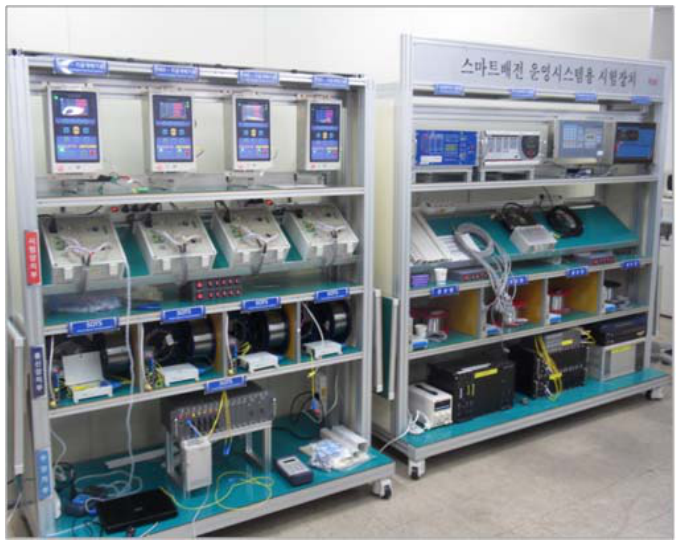
Figure 13. Test devices of automatic fault